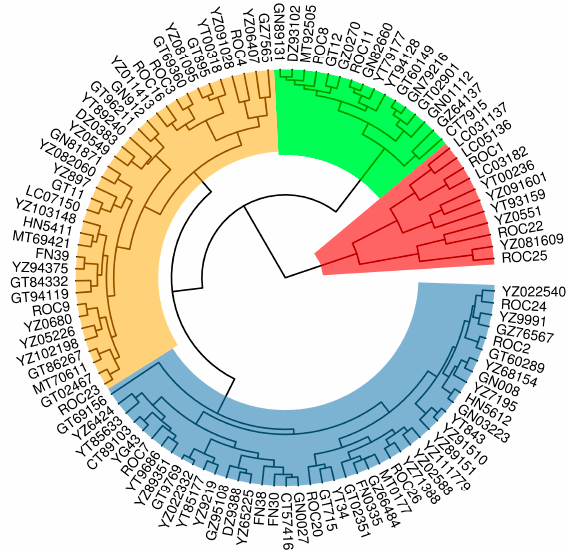
Figure 1. Cluster analysis of the 107 sugarcane variety resources examined here. The red area represents group 1, green represents group 2, yellow represents group 3, and grey represents group 4. Agronomic characteristic data were processed using a reciprocal approach, while the industrial characteristics were processed via an arcane process, then all data were normalized. Analysis of agronomic characteristics among the four cluster groups revealed signif- icant differences in the single-stem weight (Figure 2A; p < 0.001). There were also signifi- cant differences in sugarcane height between all groups, except groups 1 and 2 ( p < 0.001; Figure 2B), and in leaf disease incidence, except between groups 1 and 3 ( p < 0.01; Figure 2C). Significant differences in stem diameter were observed among all 4 groups ( p < 0.001; Figure 2D), and in the millable stalk count between all groups, except groups 1 and 3 ( p < 0.001; Figure 2E). Meanwhile, there were extremely significant differences between groups in terms of general vigor ( p < 0.01; Figure 2F).